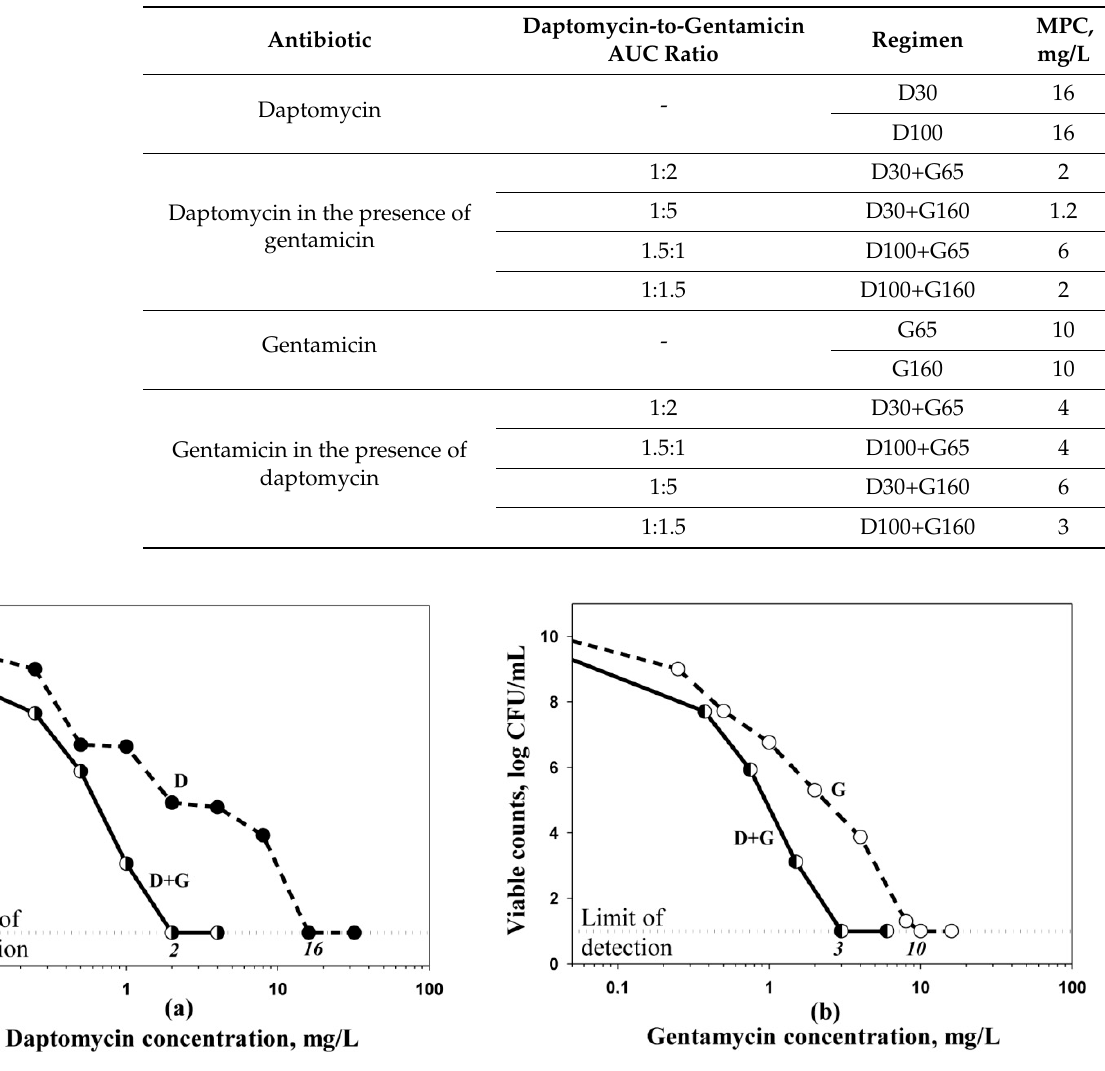
Figure 1. Determination of MPC of daptomycin (D) ( a ) and gentamicin (G) ( b ) alone and in combination at concentration ratio 1:1.5, respectively, against S. aureus 293.